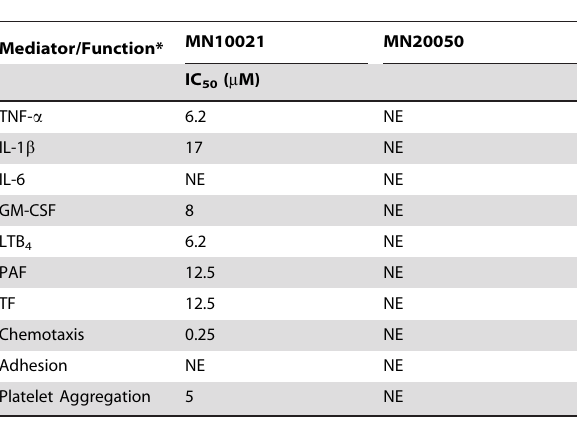
Table 1. Pharmacological Profile of